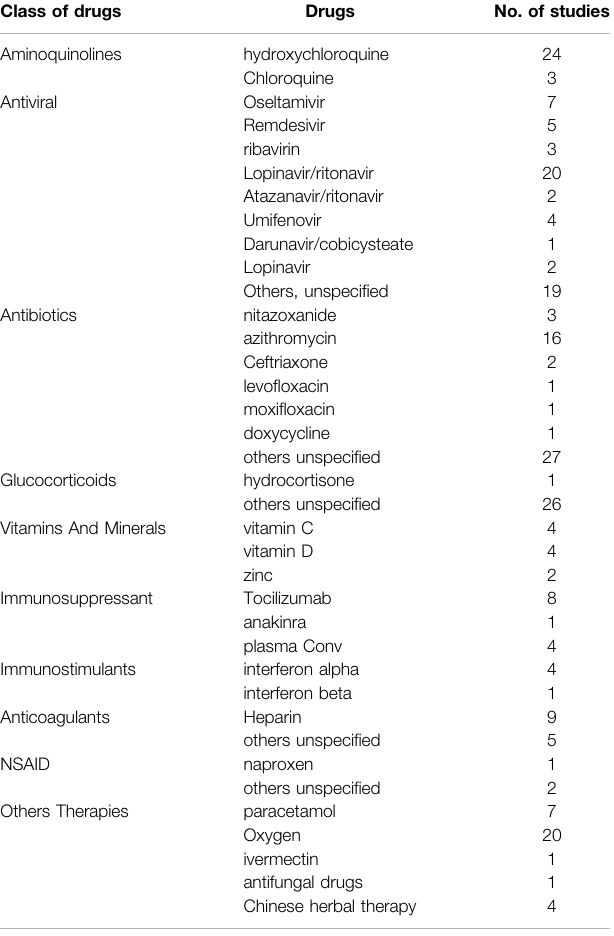
TABLE 1 | Active agents allowed in the studies with standard of care including treatments under investigation for COVID-19